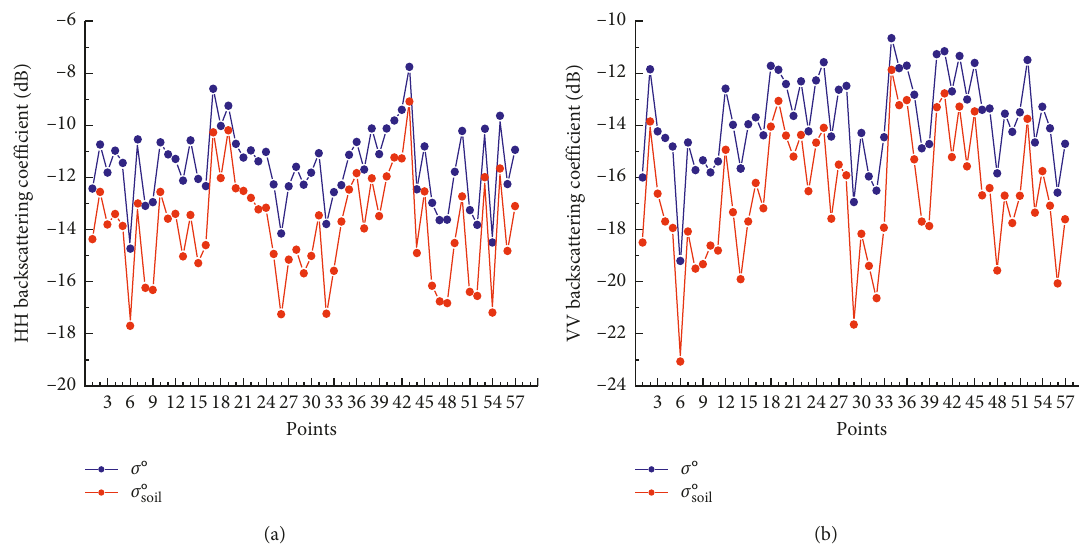
Figure 6: Changes in the backscattering coefficient (a) before and (b) after the elimination of vegetation information.